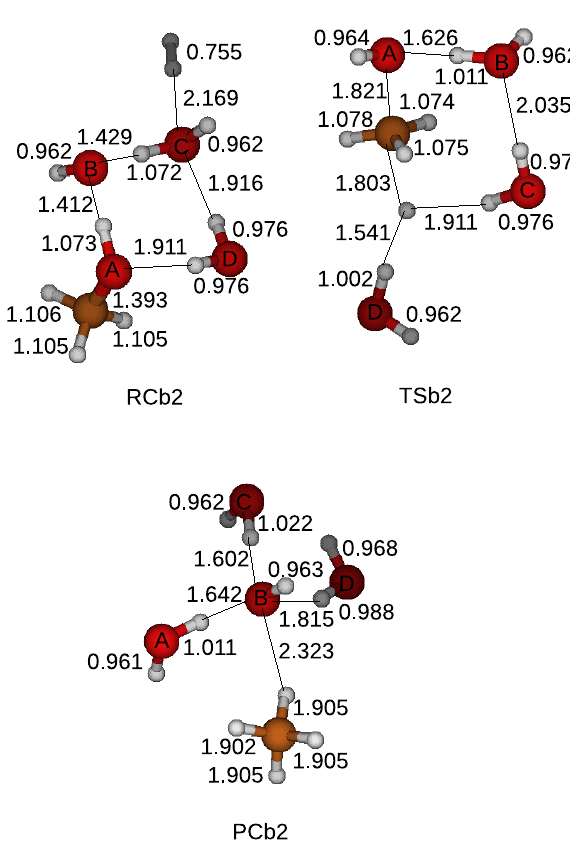
Figure 7. Calculated geometries of a reactant compound (RCb2), a transition state (TSb2), and a product compound (PCb2) for the base catalyzed reduction of a methanol. Labels (A, B, C, D) were attached to oxygen atoms to distinguish between them. A hydroxide and two water molecules are introduced in the